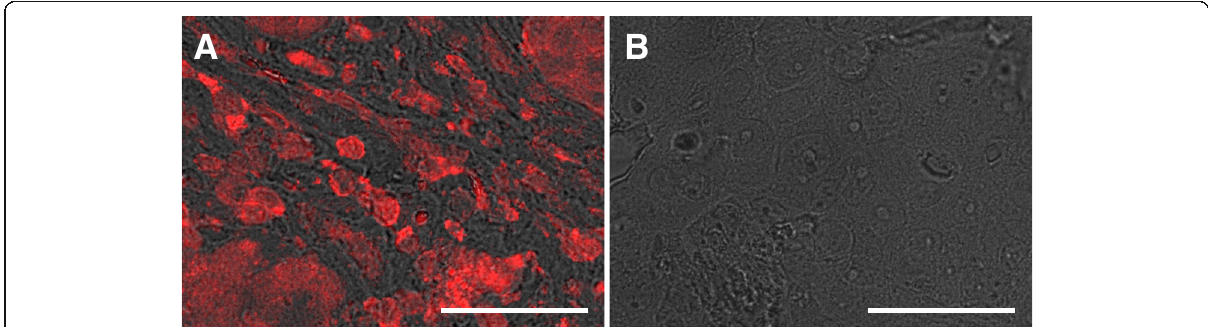
Fig. 1 Light microscopy images demonstrating the specificity of HER2 affibody-QD labelling on tumour sections. The images represent an overlay of the fluorescence signal and the direct interference contrast (DIC) signal, providing a three-dimensional impression of the sample surfaces, and the red colour originating from the QD655 ’ s fluorescence. a A tumour section exhibiting red fluorescence signals deriving from the HER2-bound QDs. The cell shapes are visible from the DIC signal in grey. b Example of a negative control experiment, performed with another section from the same tumour, and the same labelling protocol, except that the HER2 Affibody incubation was omitted. The exposure settings of the fluorescence channel were the same for both images. Scale bars 50 μ